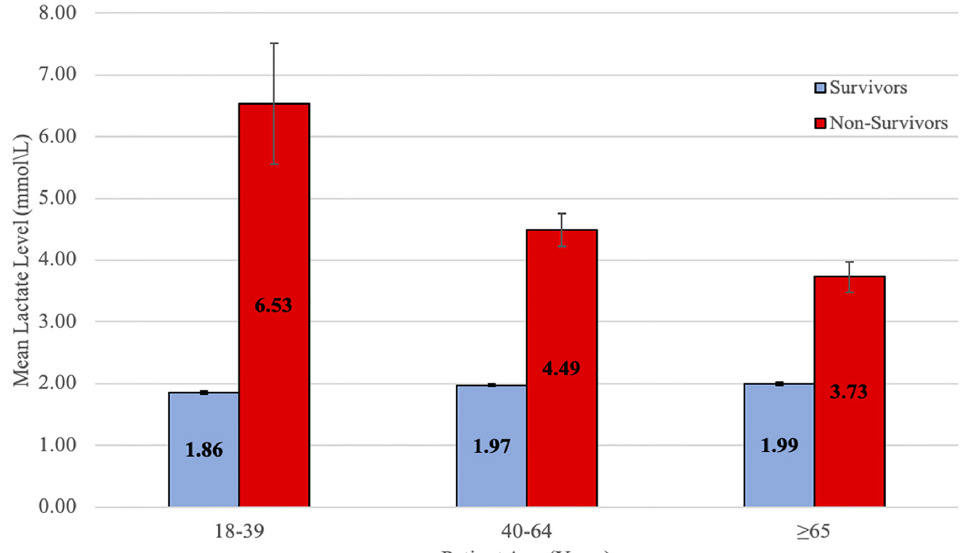
Figure 3. ED mean lactate level of survivors and non-survivors. mmol/L , millimoles per liter, ED, emergency